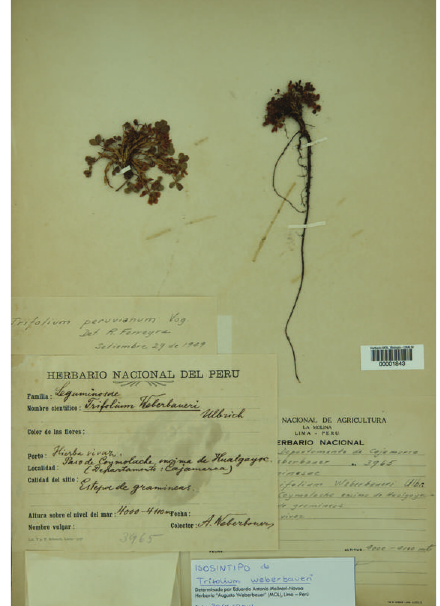
Figure2: Weberbauer3965 :lectotypeof Trifolium weberbaueri Ulbr. (= T. peruvianum ).